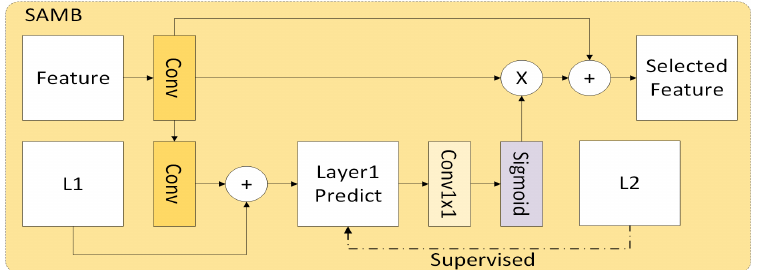
Figure 7. Architecture of the